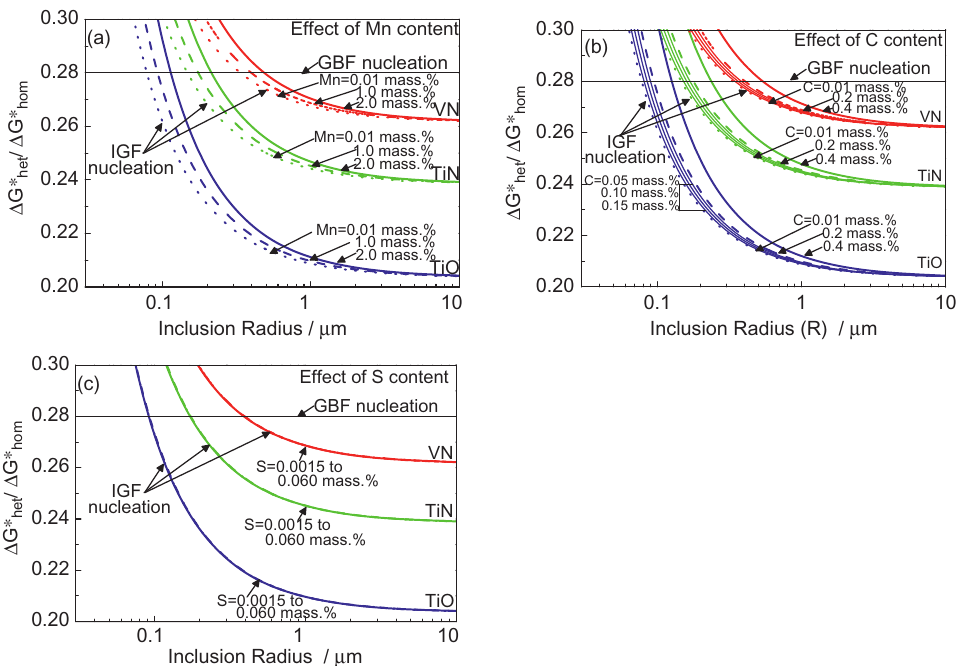
Figure 14: Effects of (a) Mn, (b) C and (c) S contents on the critical sizes of nuclei inclusions for IGF nucleation [10,